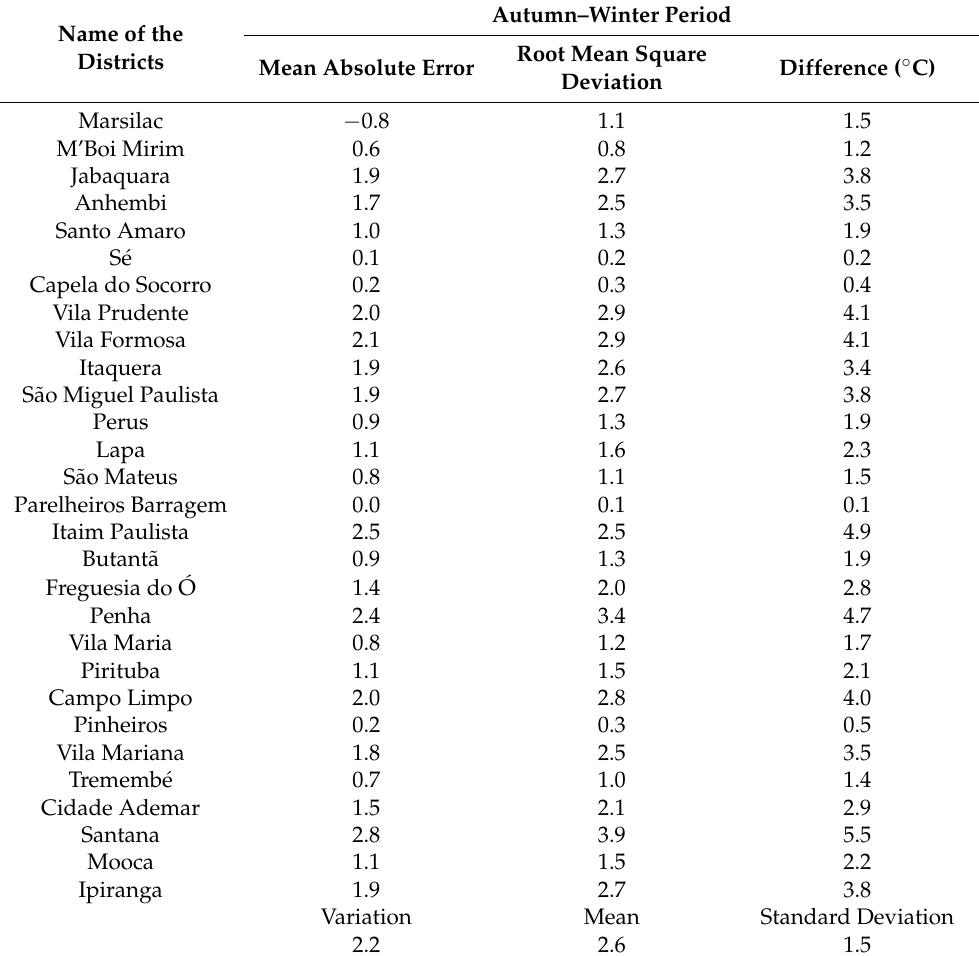
Table 4. Values of the mean absolute error (MAE) and root mean square deviation (RMSD) of the temperature estimated by the observed temperature on 17 August 2019 in the autumn–winter season. Source: Management Centre of Climate Emergencies of the S ã o Paulo City, 2019. Name of